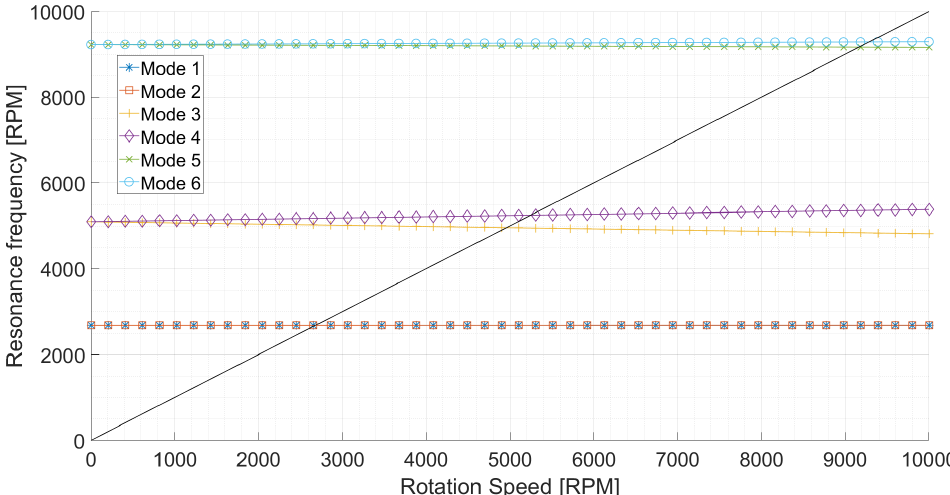
Figure 9. Campbell diagram of the rotor. The stiffness and damping are set as described in Table